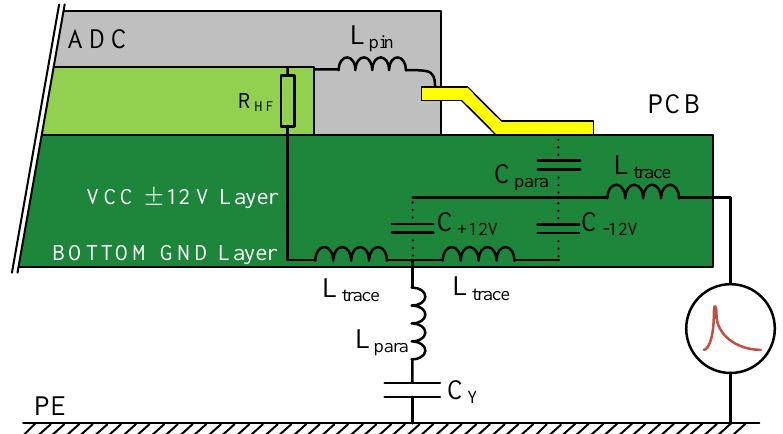
Figure 17. Acquisition card’s ADC peripheral circuit model.